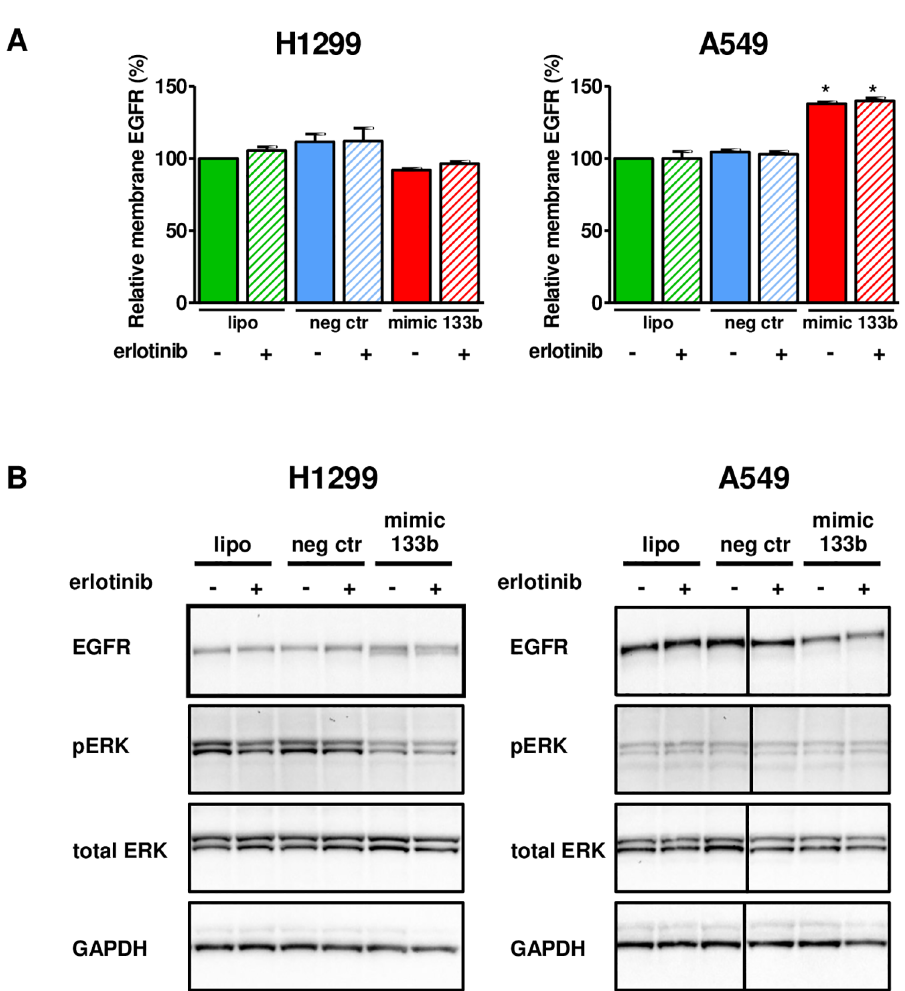
Fig 3. Effects of mir-133b and erlotinib on EGFR and EGFR pathway. A Flow cytometry to evaluate EGFR surface expression. Expression relative to lipofectamine treated cells is shown (mean ± SEM of three independent experiments is shown). (cid:3) p < 0.05 by the one sample t test with hypothetical value = 100. B Western blot assay to detect total EGFR, total ERK, GAPDH and phosphorylated ERK. Cropped blots are displayed. Full length blots are showed in S1